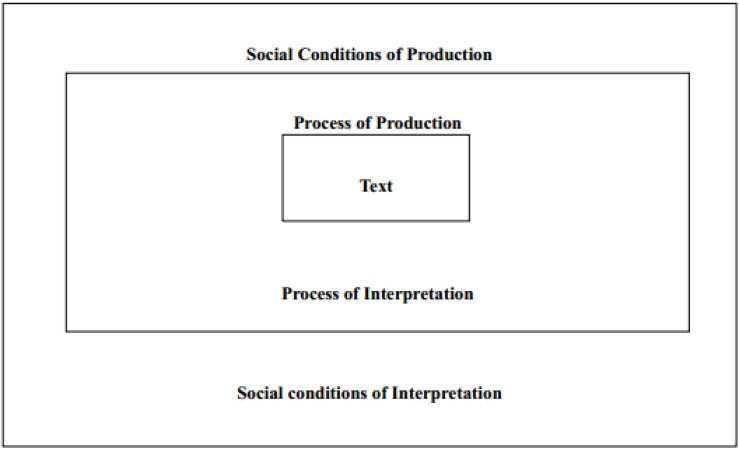
Fairclough’s three-dimensional model (Fairclough, 2001, p. 21). Adopted from: Fairclough (2001).